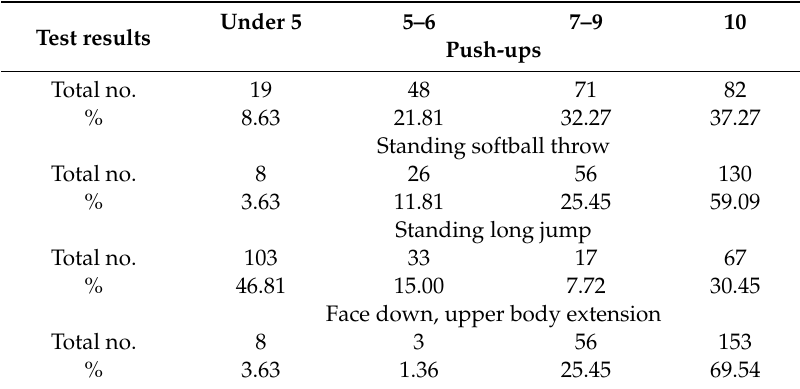
Table 5 highlights the results on the correlation between body mass index (BMI) and the motor skills tests. Table 4. The results in motor skills tests.